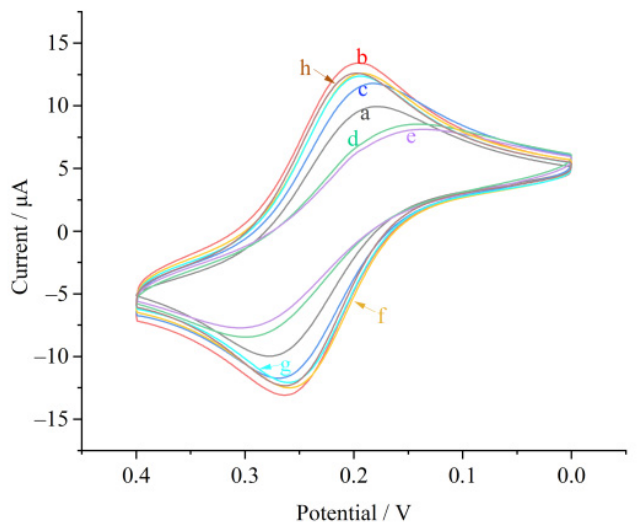
Figure 1. Typical CV curves of (a) bare GCE; (b) AuNPs/GCE; (c) aptamer/AuNPs/GCE; (d) Aptmer/MCH/AuNPs/GCE; (e) Pb (II)/Aptmer/MCH/AuNPs/GCE; (f) CS–GO/Pb (II)/Aptmer/MCH/AuNPs/GCE; (g) CHO/CS–GO/Pb (II)/Aptmer/MCH/AuNPs/GCE; (h) aptamer-IIP-Pb (II) in 5 mM [Fe (CN) 6 ] 3 − / 4 − and 0.1 M KCl.